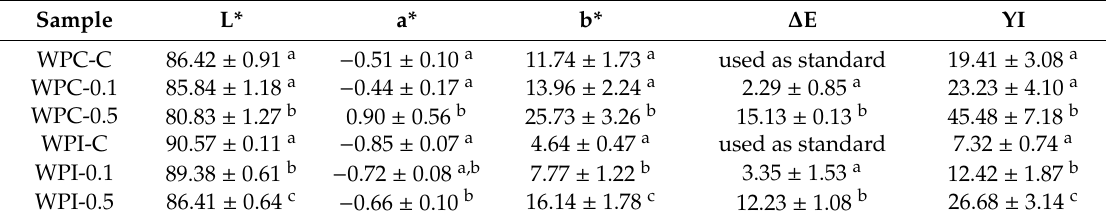
Table 3. Color parameters (L*, a*, b*), total color di ff erence ( ∆ E), and yellowness index (YI) of neat WPC / WPI and melanin-modified